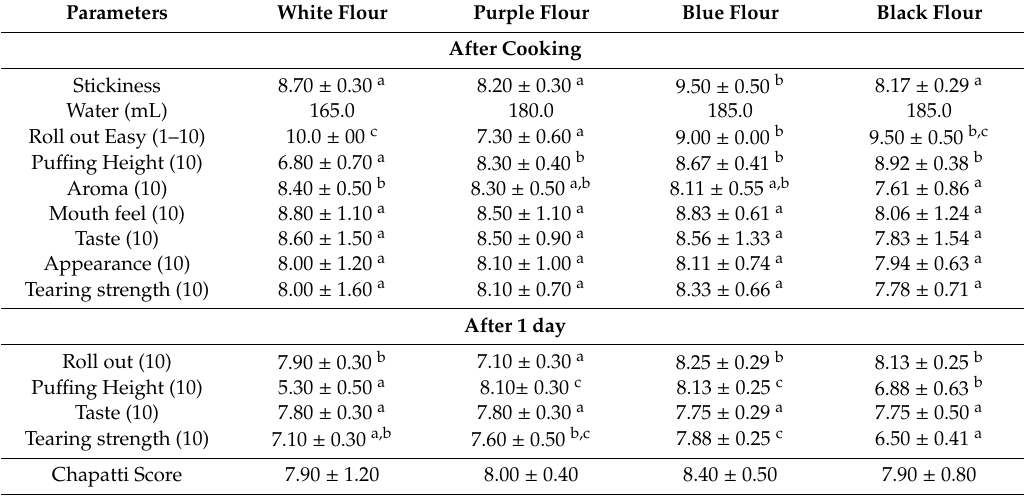
Table 2. Sensory evaluation of colored wheat chapattis.